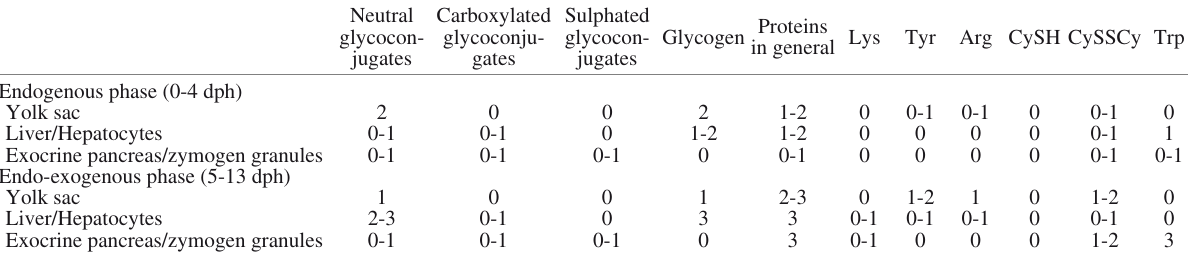
Table 4. – Histochemical distribution of glycoconjugates and proteins during the endo-exogenous phase (0-13 dph) of Chelon labrosus. Re- sults are expressed as semi-quantitative assessment of colour intensities or histochemical reactivity. Estimated scale to evaluate the presence of macromolecules: 0, negative or unreactive; 1-2, weak-moderate staining; 3-4, strong reactivity. Neutral glycocon-